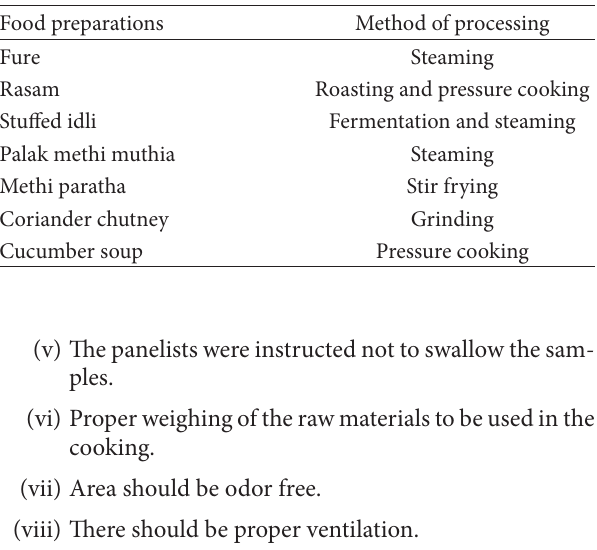
Table 1: Food preparations prepared with different methods of cooking by incorporating Catharanthus roseus fresh